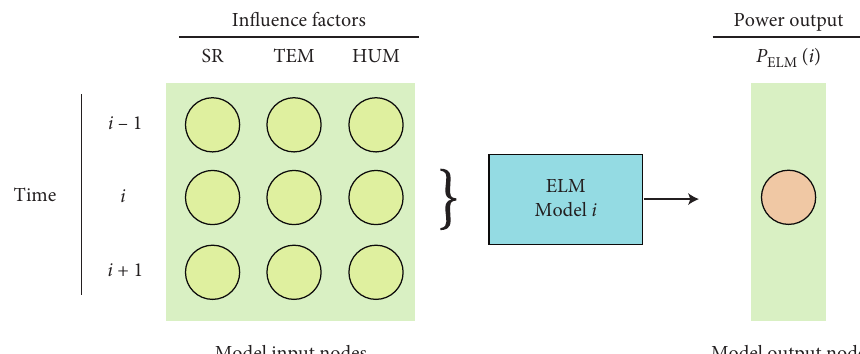
Figure 7: The multimodel univariate ELM forecasting model at time i of the forecasting day.